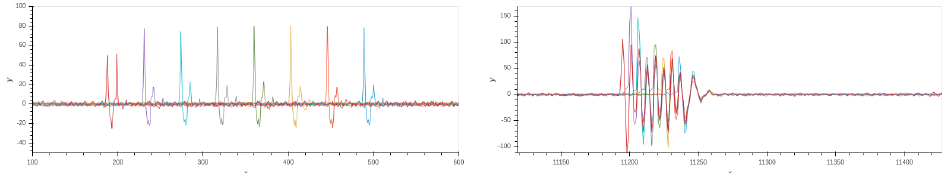
Figure 9: The intervals [100:600] and [11100:11500] of Fig. 8 representing the processing of the first byte of the share m ⊕ r by poly_A2A() and POL2MSG() , respectively.